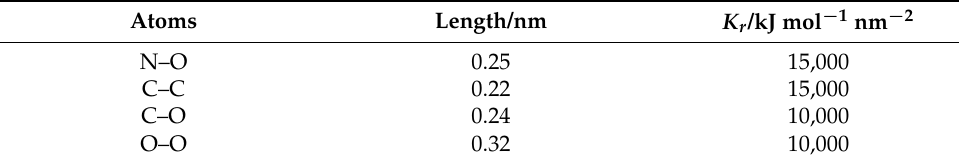
Table 2. Bond parameters for CG models of CB7CB.